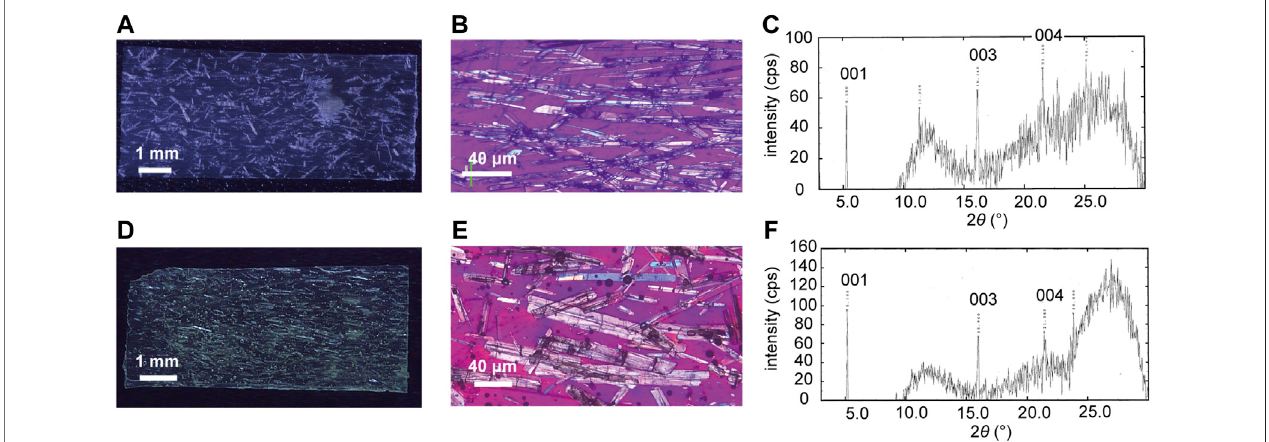
FIGURE2|(A,D)(A) Asiliconepolymerhybrid fi lm(8.6 mmlong × 3.7 mmwide × 100 μ mthick)and (D) aUV-curedresinhybrid fi lm(7.0 mmlong × 3.0 mmwide × 126 μ mthick)inwhichenol- 1 crystalsarealignedbyrubbing. (B,E) Enlargedpolarizedmicroscopicimagesof (B) thesiliconepolymerhybrid fi lmand (E) theUV-cured resin hybrid fi lm. (C,F) XRD pro fi les of (C) the silicone polymer hybrid fi lm and (F) the UV-cured resin hybrid fi